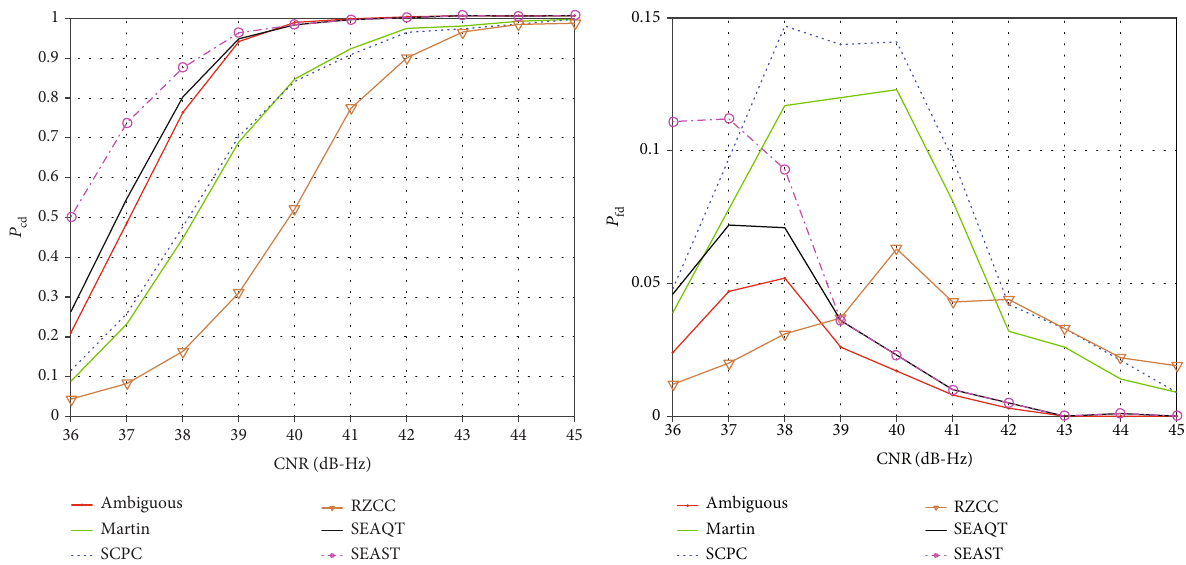
Figure 17: Correct detection probability and false detection probability for cos-BOC (15, Table 1: Comparison of capture performance for di ff erent algorithms. BOC signal